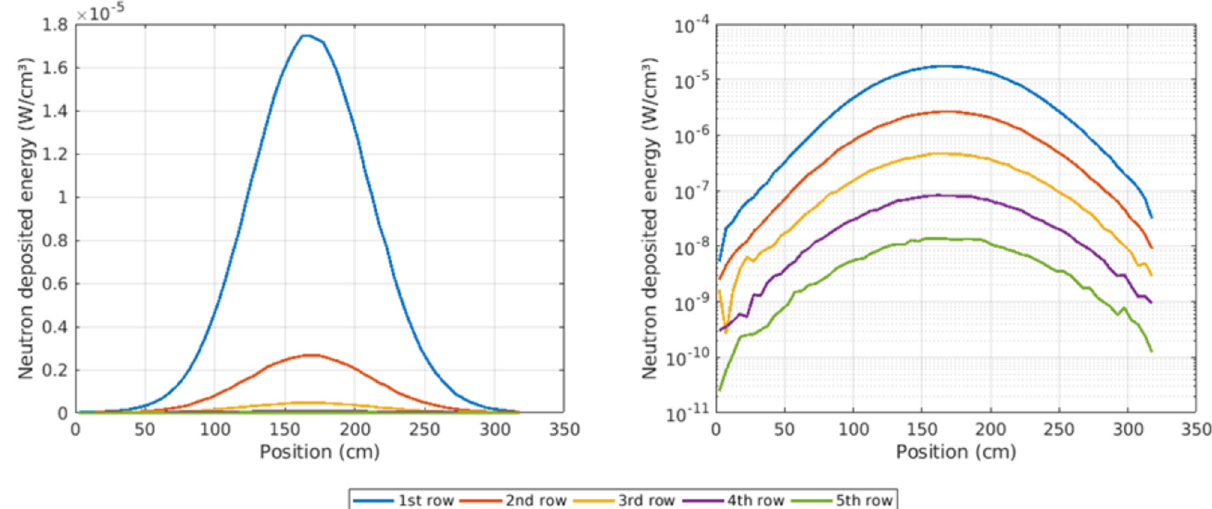
Fig. 22. Axial traverses of the neutrons deposited energy in the hexagonal tube of neutron shielding, linear scale (left), logarithmic scale (right).